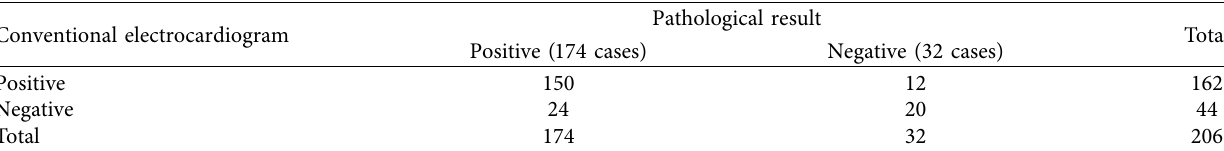
Table 1: Diagnostic efcacy of conventional electrocardiogram for asymptomatic myocardial ischemia with arrhythmia in elderly patients with CHD ( n ).